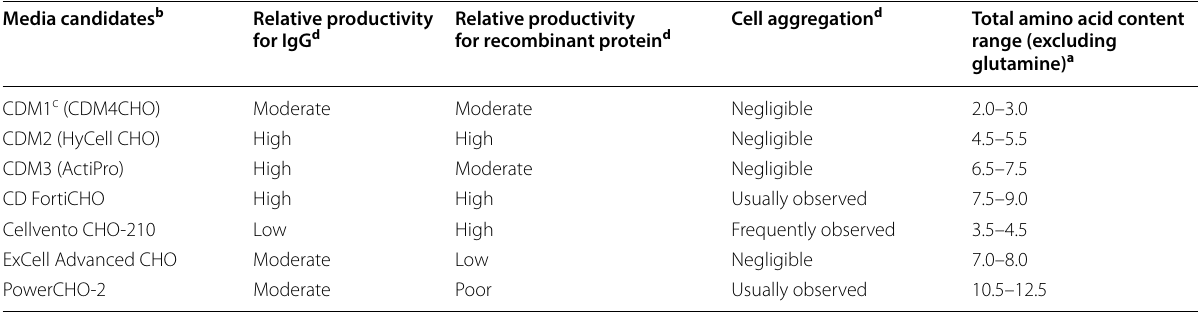
a Expected ranges are from internal amino acid analysis and/or references (Reinhart et al. 2015; Carrillo-Cocom et al. 2015; Pan et al. 2017). Amino acids are detected (and reported in publications) as molar mass, so the amino acid concentration is calculated with molecular weight b CDM4CHO (GE Healthcare, Björkgatan, Uppsala, Sweden), HyCell CHO (GE Healthcare, Björkgatan, Uppsala, Sweden), ActiPro (GE Healthcare, Björkgatan, Uppsala, Sweden), CD FortiCHO (Thermo Fisher Scientific, Waltham, MA, US), Cellvento CHO-210 (Merck KGaA, Darmstadt, Germany), ExCell Advanced CHO (SAFC Bioscience, St, Louis, Mo, USA), PowerCHO 2 (Lonza, Verviers, Belgium) c